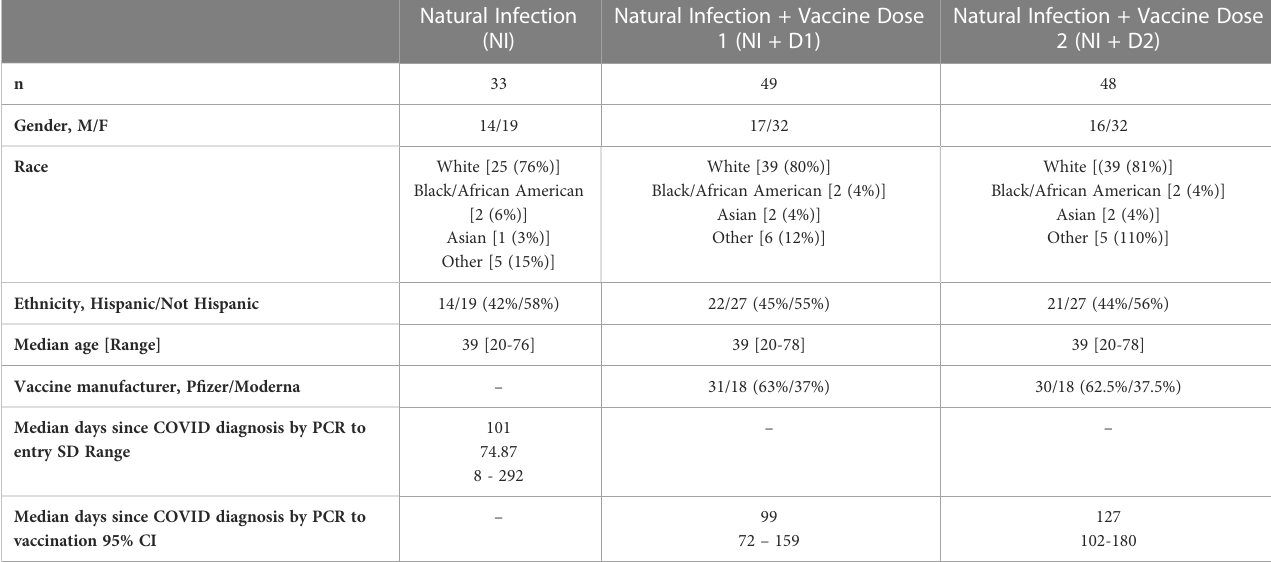
TABLE 1 Characteristics of the study population following natural infection, 1st dose of vaccine, and 2nd dose of